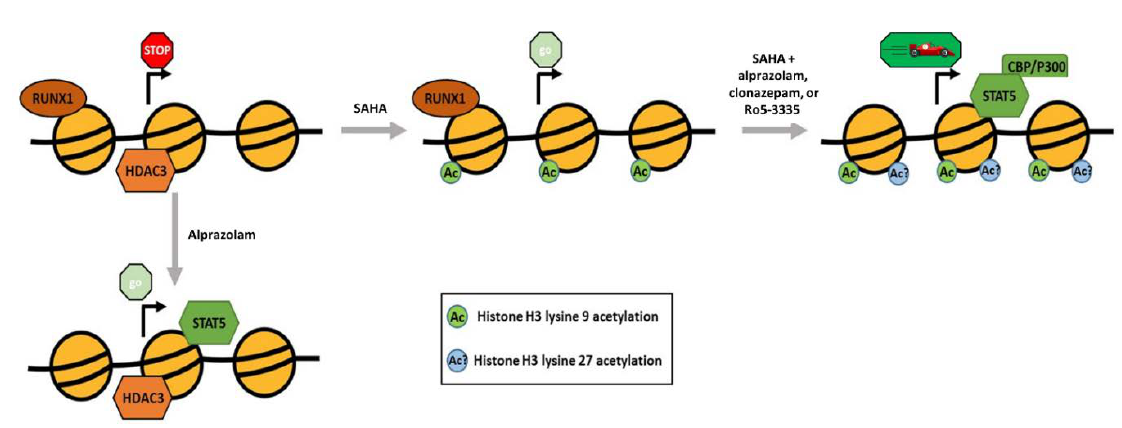
Figure 8. Model for the proposed effect of Alprazolam and SAHA on the HIV-1 LTR. A graphical representation of the nucleosomes (yellow circles) surrounding the transcription start site (arrow) in the integrated HIV-1 LTR. The association of proteins with the chromatin, acetylation state of the histones and relative amount of transcription are presented for each condition.